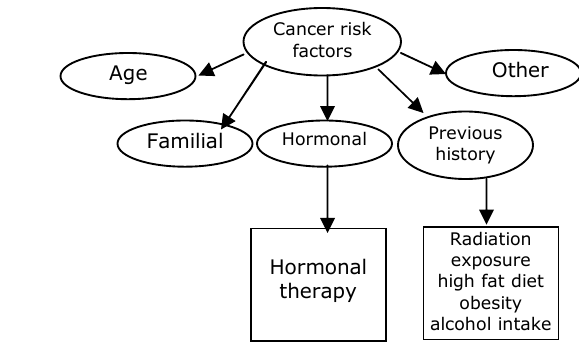
Figure 2a . Other diagnostic methods.